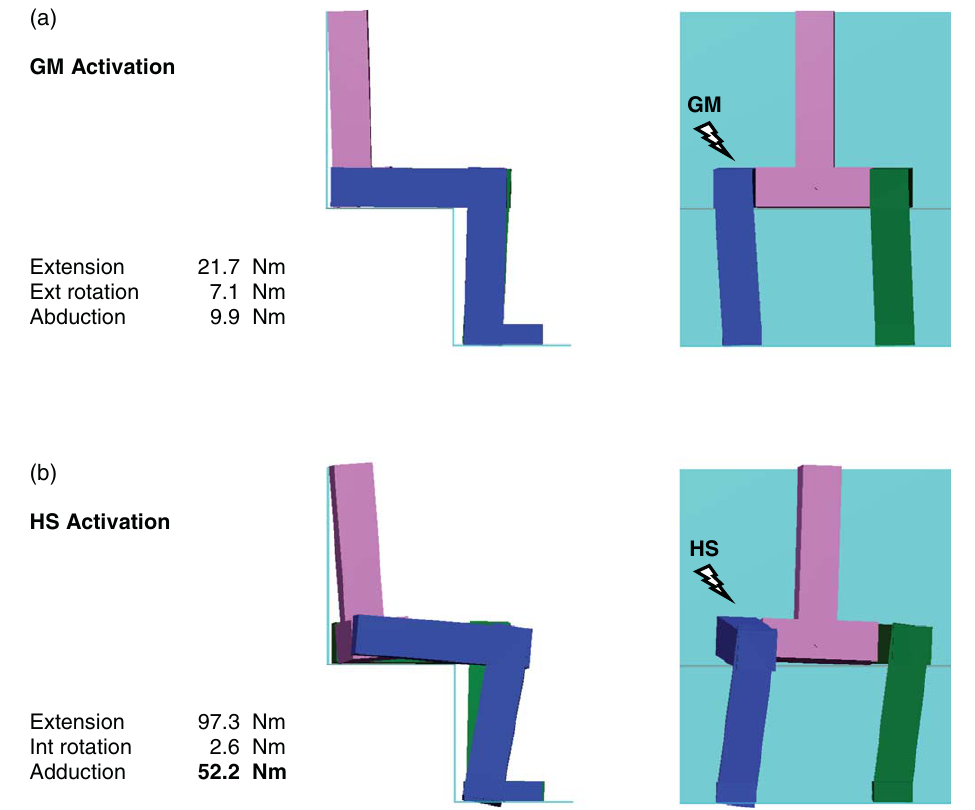
Fig. 5. Rigid body simulations of activating GM (upper panel) and HS (lower panel) using full pattern of torques in all three axes (from Fig. 3); shown to maximal “unloading” for GM (reached at 1.5s) and successful unloading for HS (reached at 0.2s). Note: with HS activation the position of the center of mass does not shift forward significantly, as although there is a shift of pressure towards the thighs, this is countered as the hip extends the torso towards the seatback. This is seen (in the extreme) here. Absolute values provide gross estimates only (due to model limitations), but their relative magnitudes support important differential effects: HS activation results in ischial elevation; GM activation causes lateral sliding of thigh without elevation, which could tend to increase